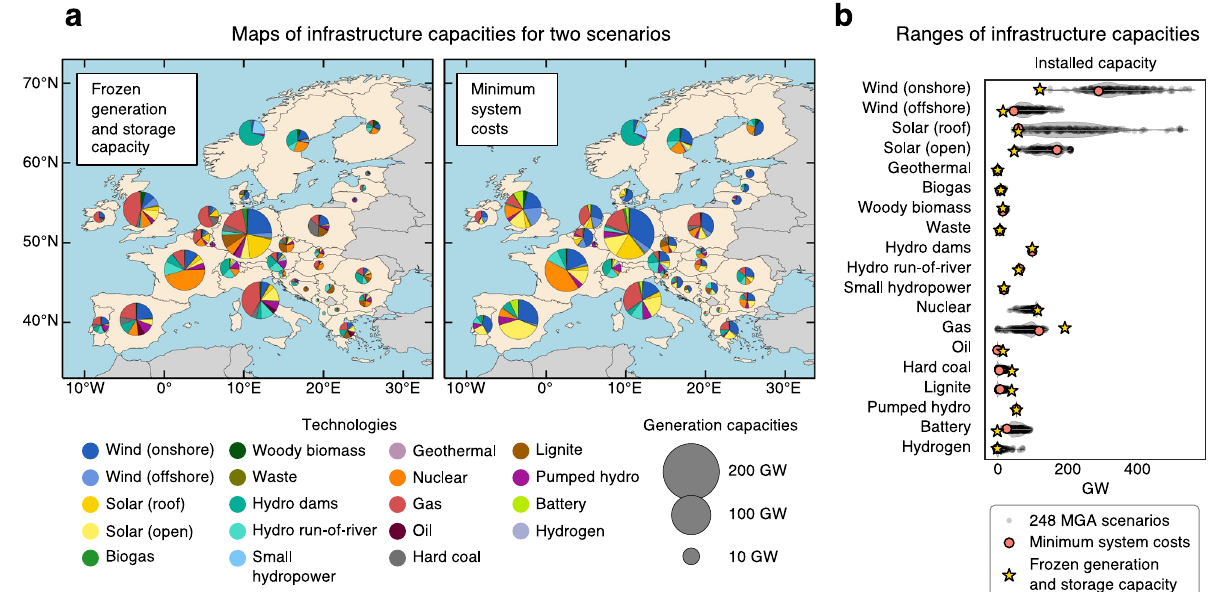
Fig.1|Analyzedscenariosofelectricitysysteminfrastructurein2035.a Mapsof electricity generation and storage capacities for the scenario of frozen generation and storage capacity and the scenario of minimum system costs. The frozen sce- nario assumes that generation and storage capacities of 2035 are as in 2018, but that transmission capacities can increase to accommodate the higher electricity demand of 2035. The scenario of minimum system costs is found through opti- mization.Forvisualizationpurposes,installedcapacitiesareshownatcountry-level instead of NUTS-2 level 46 . Background maps: Made with Natural Earth. Detailed